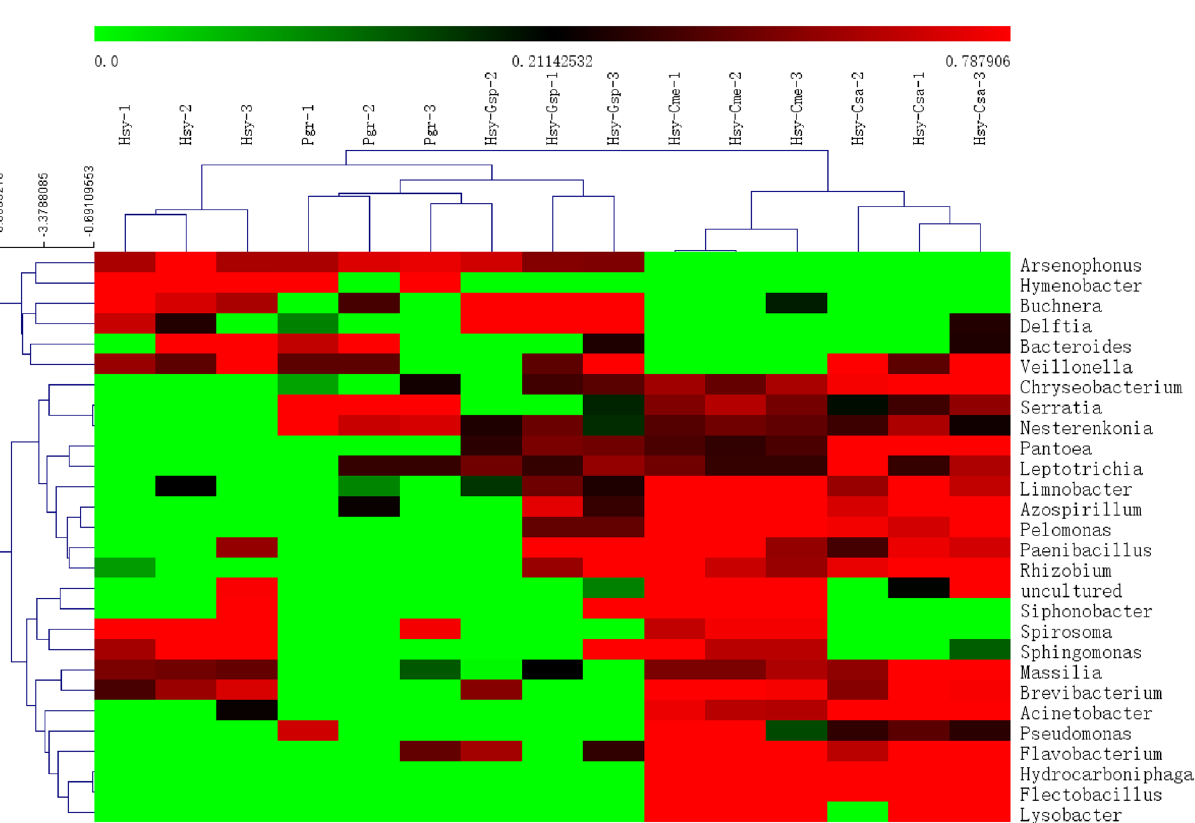
Figure 5. Heat map of the relative abundances (log 2 transformed) of IBCs among Hsy, Pgr, Hsy-Gsp, Hsy- Cme and Hsy-Csa based on 16S rDNA gene Illumina sequencing. There were 3 parallel experiments in each treatment. The color gradient ranges from the minimum value in green to the maximum value in red. The expression values used were the Z value of normalized reads number. The clustering method of bacteria is HCL (Hierarchical Clustering). The sample tree was clustered with Euclidean